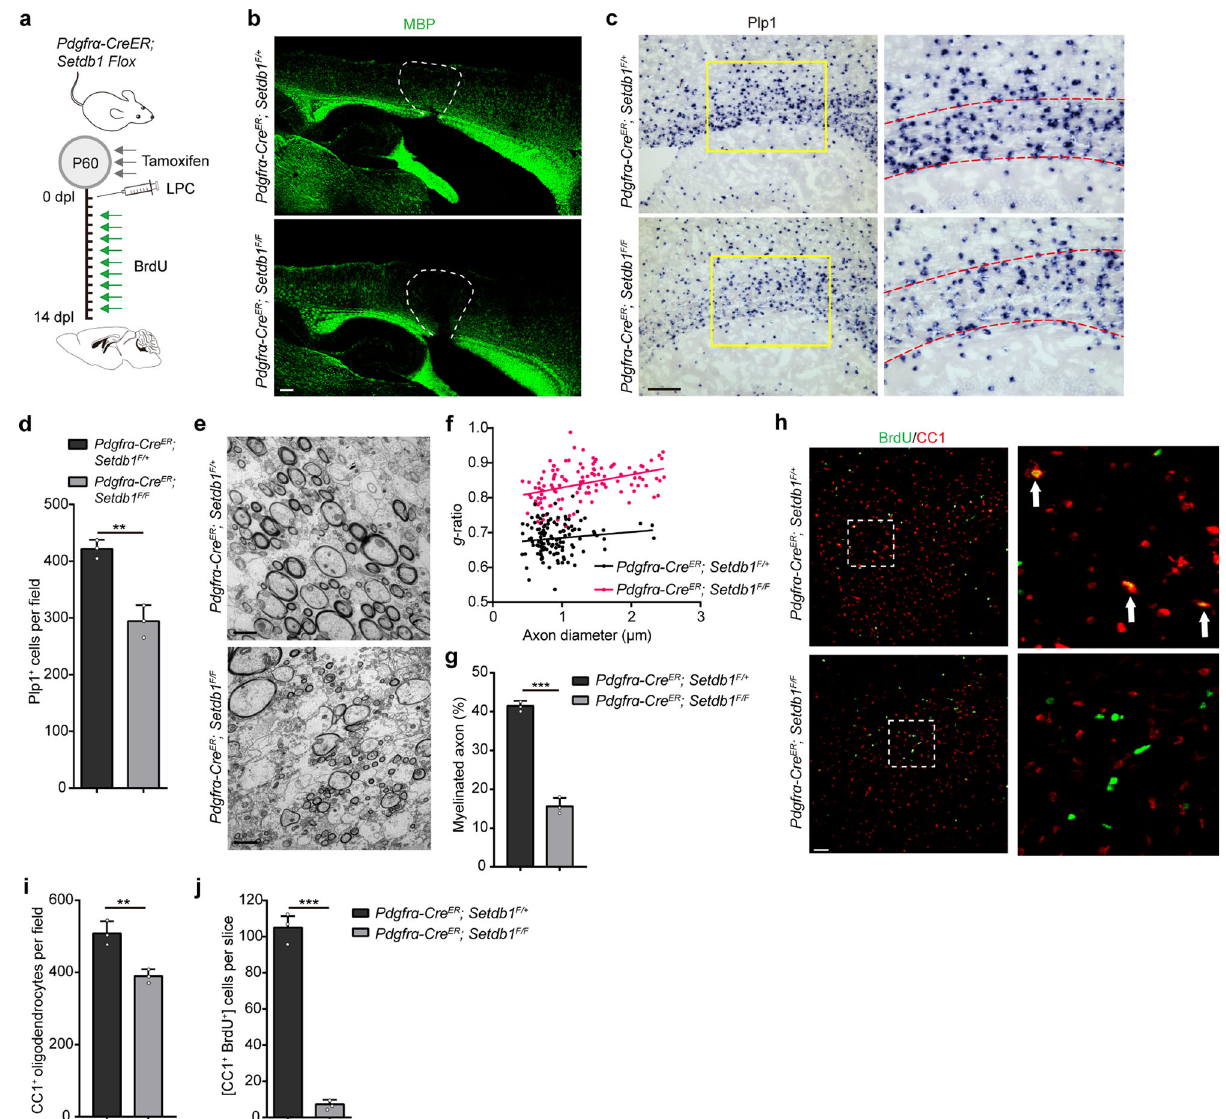
Fig. 4 SETDB1 is critical for proper myelin repair after demyelination. a Schematic diagram showing tamoxifen administration to Pdgfra-Cre ER ; Setdb1 Flox mice in 3 consecutive days at P60, followed by LPC injection and BrdU administration. Brain tissue were collected at 14 Dpl. b Immunolabeling of MBP in the LPC lesions of Pdgfra-Cre ER ; Setdb1 F/ + and Pdgfra-Cre ER ; Setdb1 F/F mice at 14 Dpl. n = 3 control and three mutant mice. c In situ hybridization of Plp1 in the lesions at 14 Dpl. Boxed areas in left panels are shown at a high magni fi cation in corresponding right panels. n = 3 control and three mutant mice. d Quanti fi cation of Plp1 + cells in the LPC lesions. Error bars indicate SEM ( p = 0.0023. two-tailed unpaired Student ’ s t test). e Electron micrographs in corpus callosum of lesions from Pdgfra-Cre ER ; Setdb1 F/ + and Pdgfra-Cre ER ; Setdb1 F/F mice at 14 Dpl. n = 3 control and three mutant mice. f Scatterplot of g - ratio at 14 Dpl in lesions area. g Percentage of remyelinated axons at 14 Dpl in lesions area. Error bars indicate SEM ( p < 0.001. two-tailed unpaired Student ’ s t test). h Immunostaining for BrdU and CC1 in LPC lesions in corpus callosum from Pdgfra-Cre ER ; Setdb1 F/ + and Pdgfra-Cre ER ; Setdb1 F/F mice at 14 Dpl. Boxed areas in left panels are shown at a high magni fi cation in corresponding right panels. n = 3 control and three mutant mice. i , j Quanti fi cation of CC1 + cells ( i ) and CC1 + /BrdU + cells ( j ) in the LPC lesions area. Error bars indicate SEM ( i , p = 0.0061; j , p < 0.001. two-tailed unpaired Student ’ s t